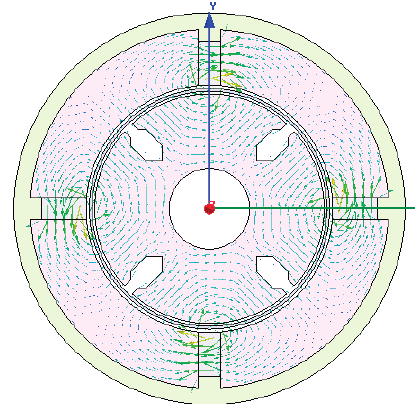
Figure 8. Distribution of magnetic flux Ф P .